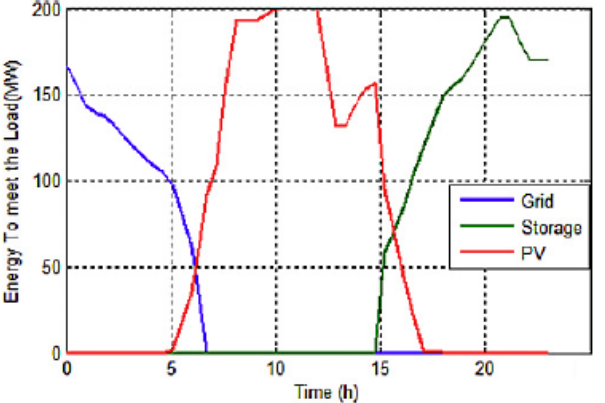
Figure 1. Energy generation to meet the demand [27].